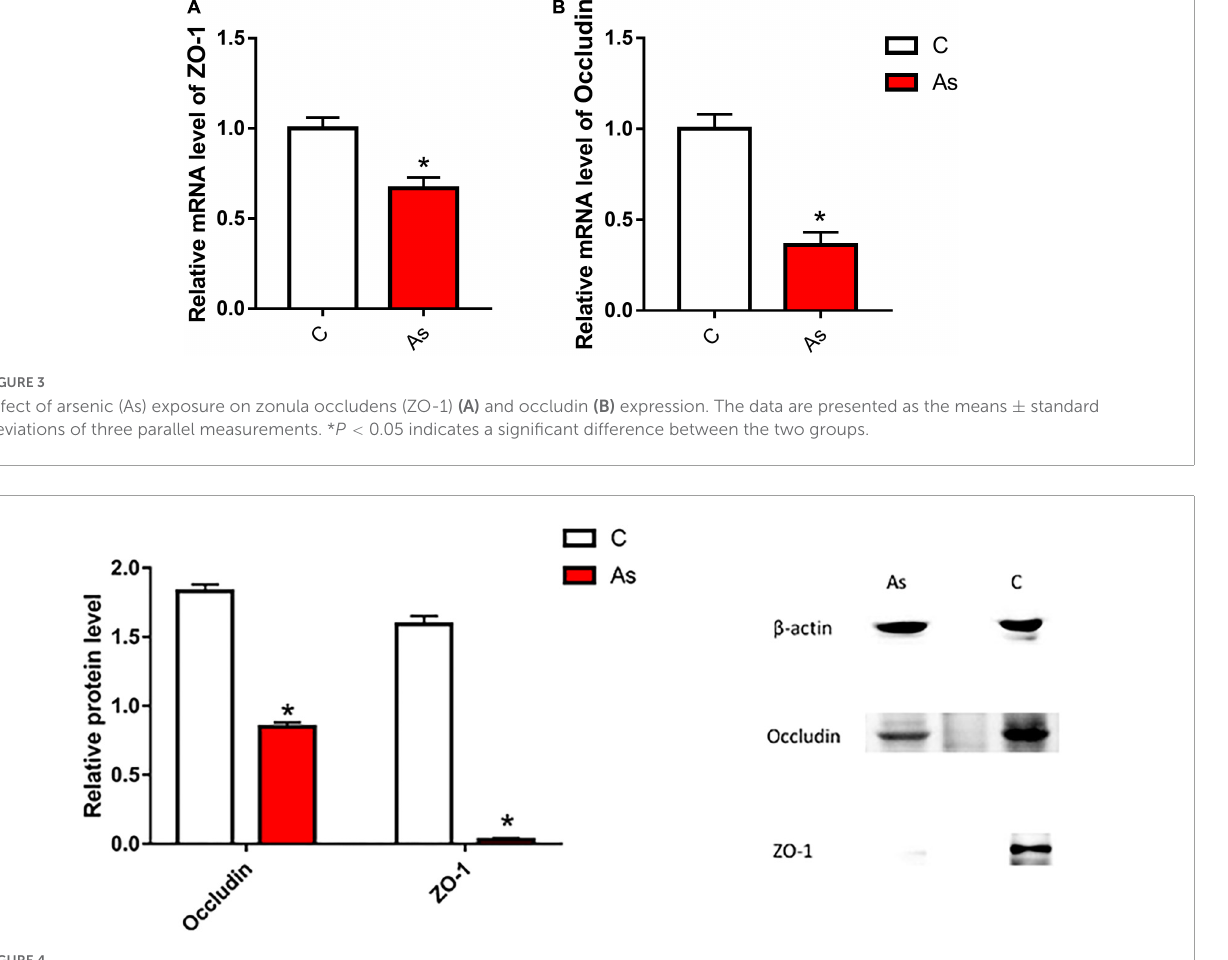
The intestine can digest, absorb, and excrete As.